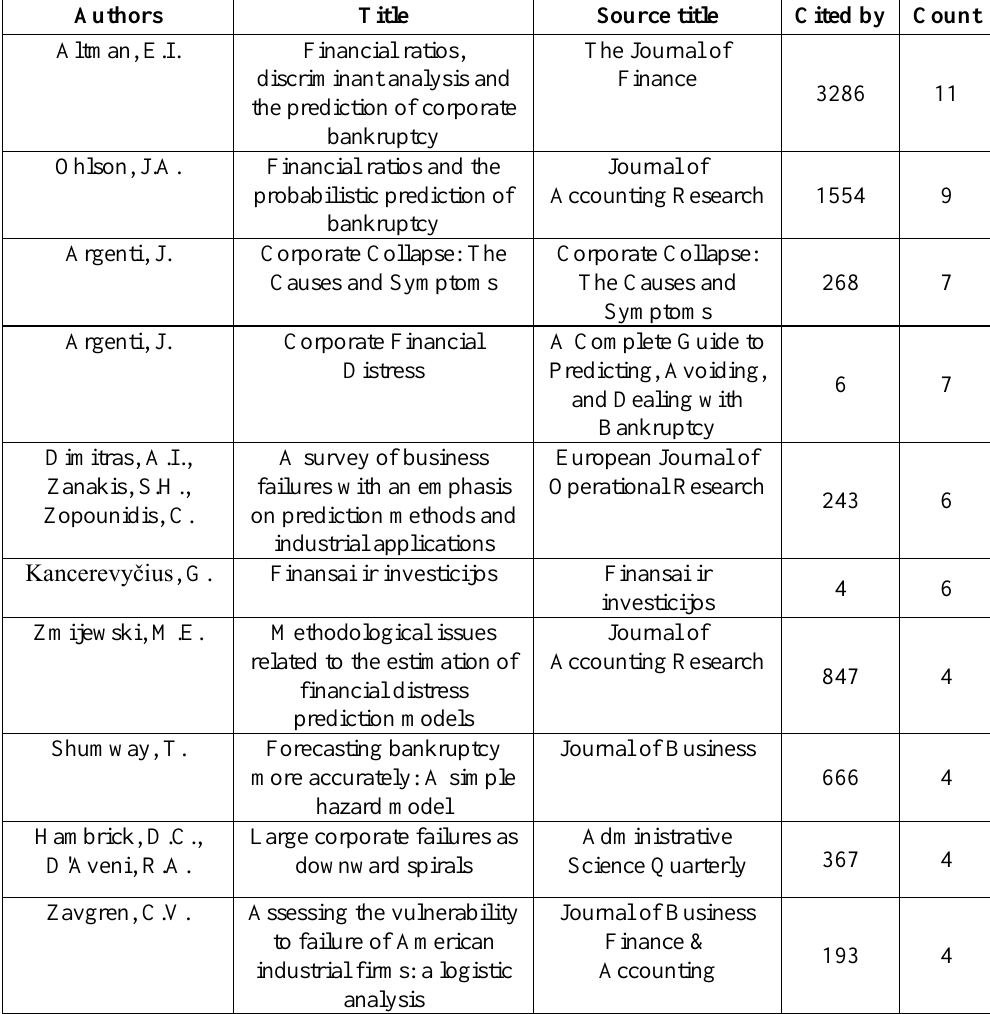
Table 3. Mostly used documents (top-10) in the search, and citation overview of